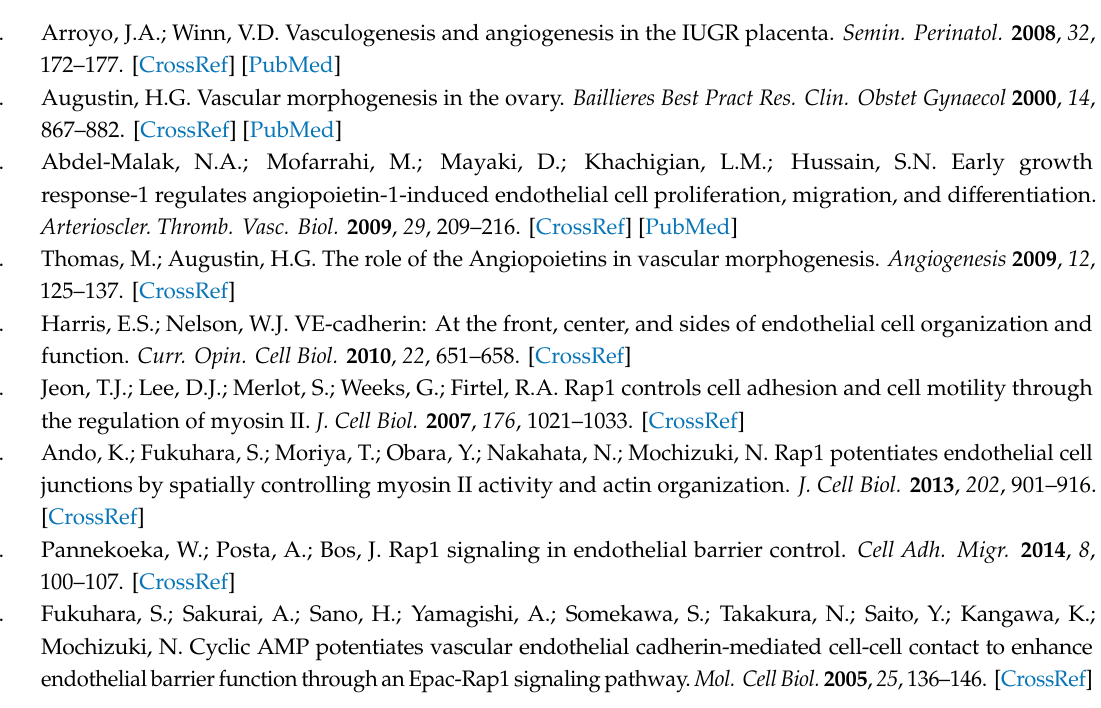
Figure S1: Validation of Rap1